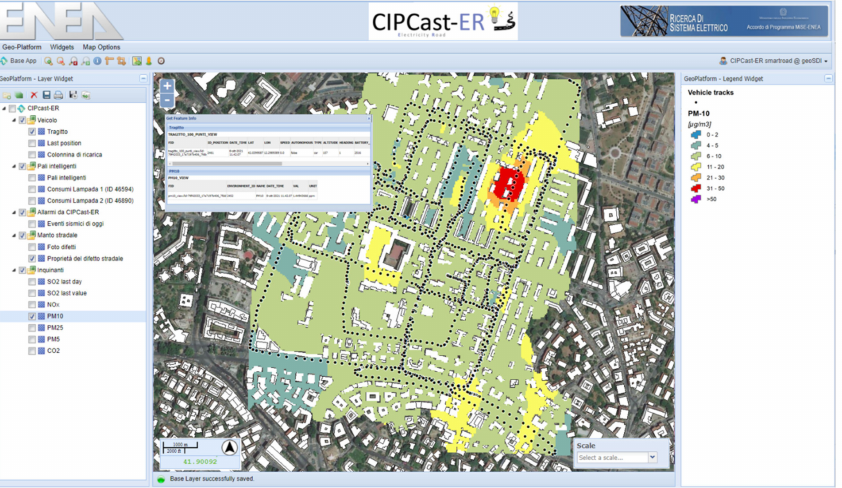
Figure 11. The CIPCast DSS: an example of a visualisation of the PM-10 map within the WebGIS